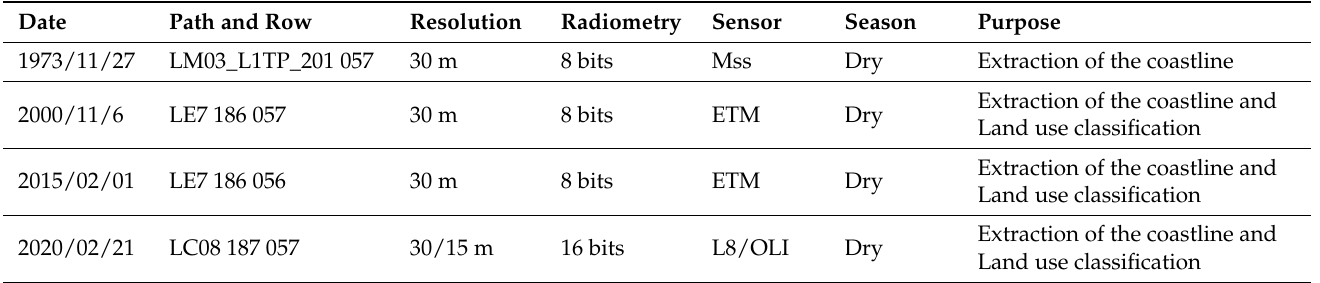
Table 1. Characteristics of processed Landsat